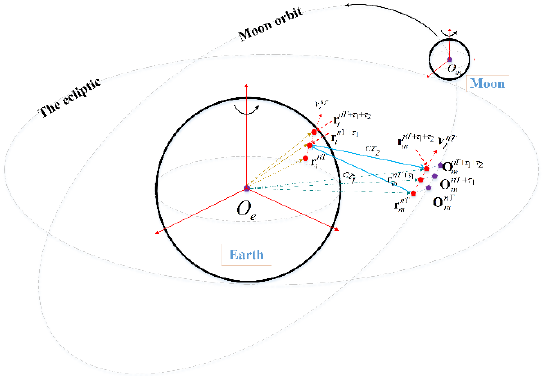
Figure 5. The signal transmission path between MBS and EGT at 𝑛 pulse Figure 5 indicates that when MBS transmits radar wave at time 𝑛𝑇 , the EGT is in 𝐫 𝑡𝑛𝑇 ; 𝑛𝑇+𝜏 1 and reflects it immediately, after a period of time 𝜏 1 , the EGT receives the wave in 𝐫 𝑡 and the MBS has moved in 𝐫 𝑚𝑛𝑇+𝜏 1 . Again, after a period of time 𝜏 2 , the MBS gets the echo